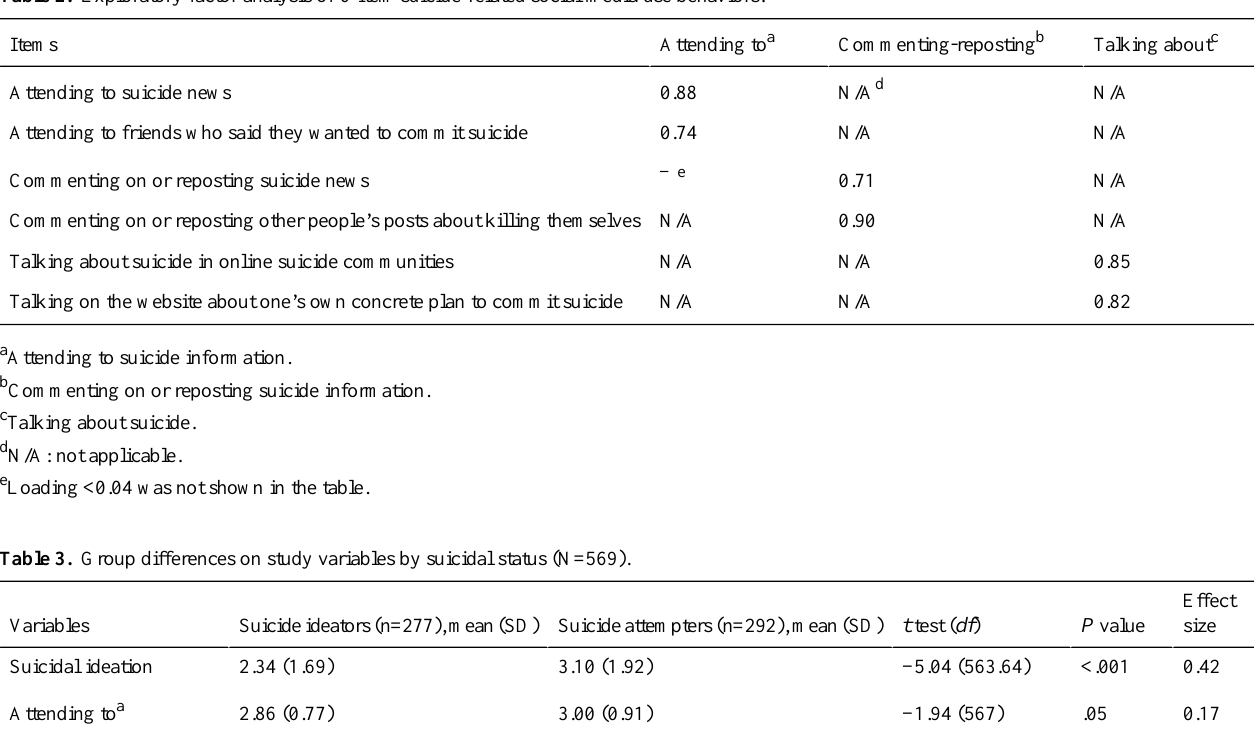
Table 2. Exploratory factor analysis of 6-item suicide-related social media use behaviors.